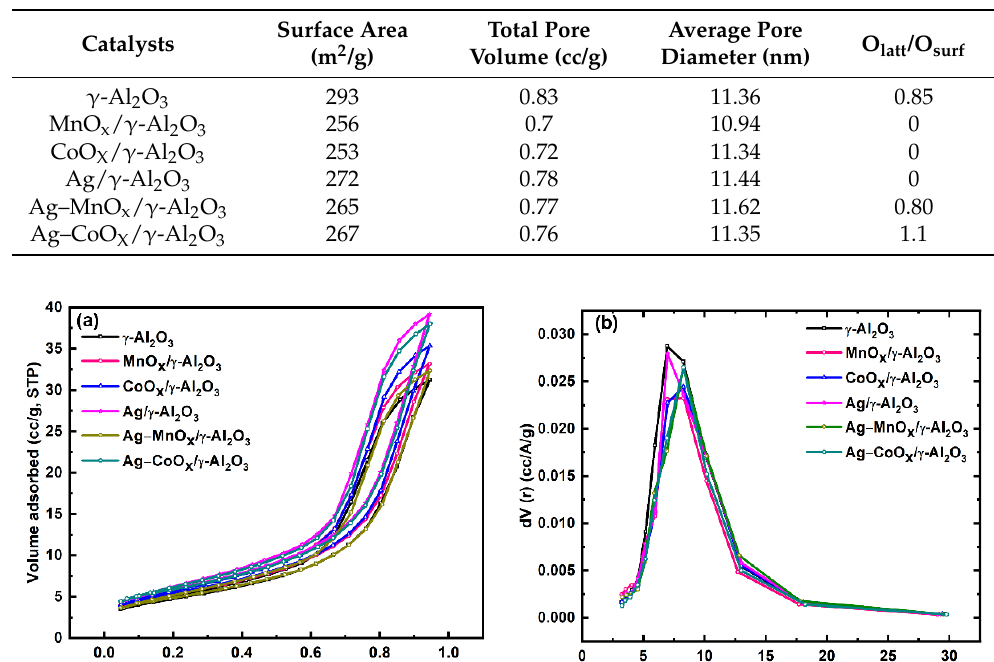
Table 1. Physio-chemical properties of the catalysts.